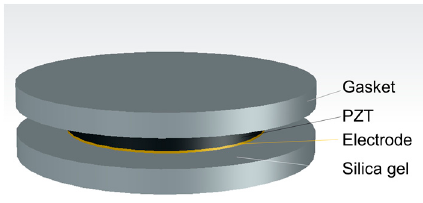
Figure 2. Schematic of the piezoelectric sensing unit. Table 1. Main performance parameters of lead zirconate titanate (PZT-4).